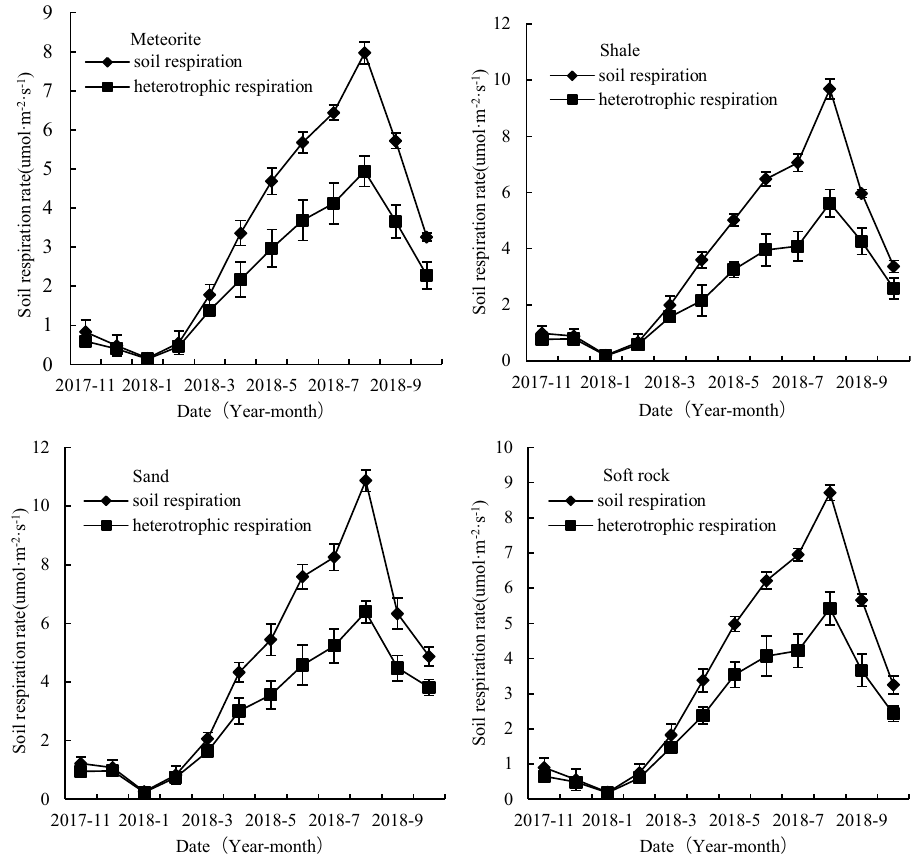
Figure 2. Seasonal changes in respiration and heterotropic respiration of the four reconstructed soils (mean ± standard